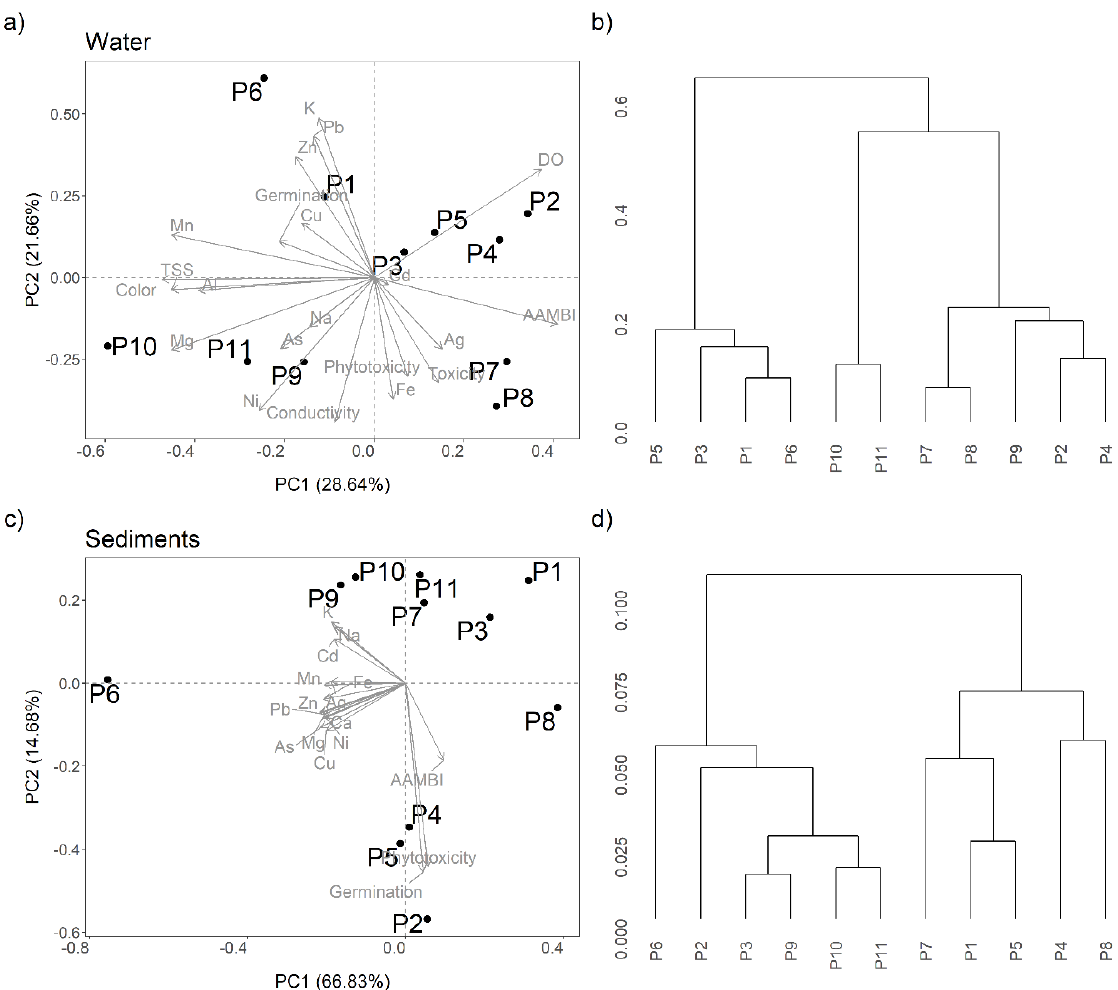
Figure 5. ( a , c ) PCA analysis for the water ( a ) and sediment ( c ) samples collected in Ecuadorian Amazon rivers affected by gold mining. The dimensional space is determined by the two first PCA axes. ( b , d ) Results of the hierarchical cluster analysis for water ( b ) and sediments ( d ). The description of the sampling sites is provided in the Table S1 of the Supplementary Materials.